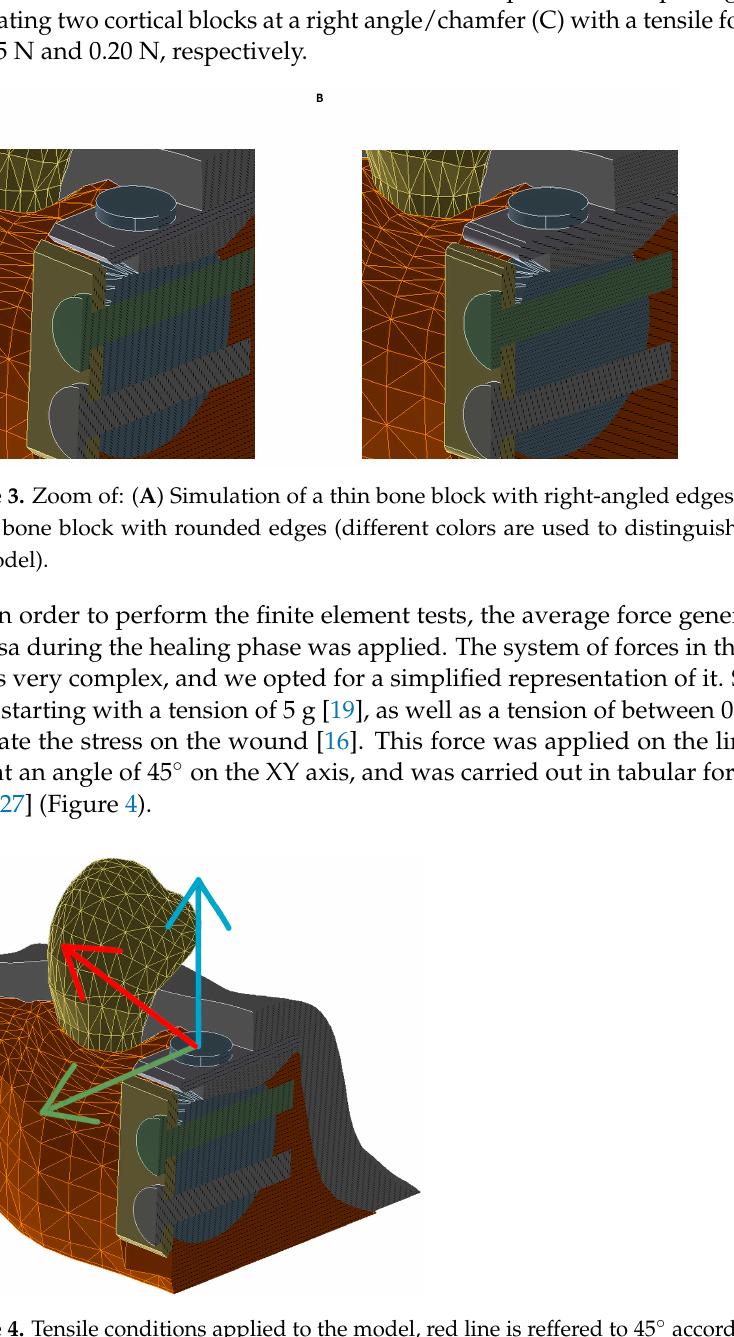
Figure 4. Tensile conditions applied to the model, red line is reffered to 45° according the direction is applied (green and blue lines indicate OX and OY axis respectively).